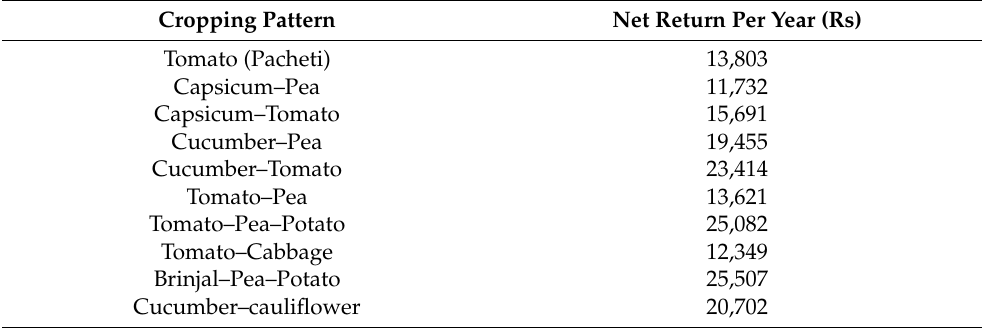
Table 11. The cropping pattern practiced under polyhouse cultivation in Almora district of Uttarakhand. Cropping